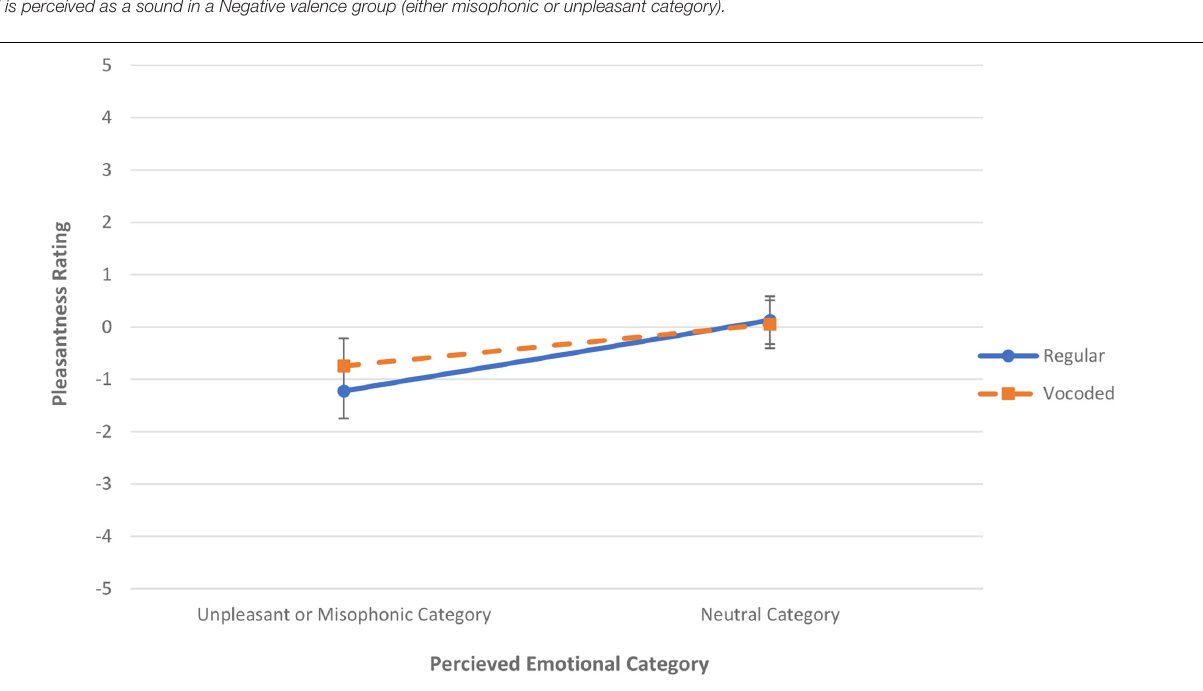
FIGURE 2 | Mean pleasantness rating versus the perceived emotional category for both regular, non-vocoded sounds (solid blue line) and vocoded sounds (dashed orange line). Ratings of sounds misidentified within the same emotional category were subaveraged. The error bars denote standard error of the mean rating across sounds. If the sound was identified (regardless of correctness) as an item in one of our a priori negative categories (either a misophonic or unpleasant sound) then it contributed to a data point on the left, whereas if the sound was identified as an item in our neutral category (regardless of correctness), contributed to a data point on the